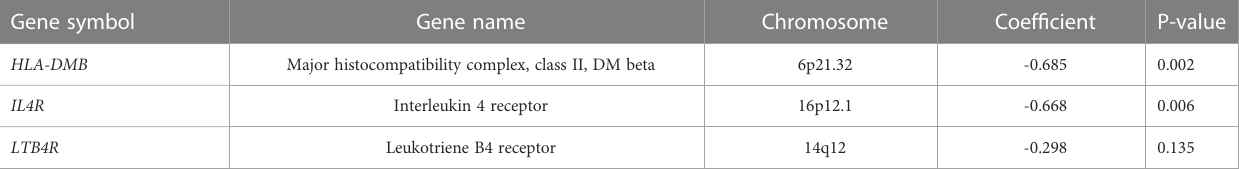
TABLE 2 Three gene members of the IRG signature associated with 28-day mortality of sepsis patients.